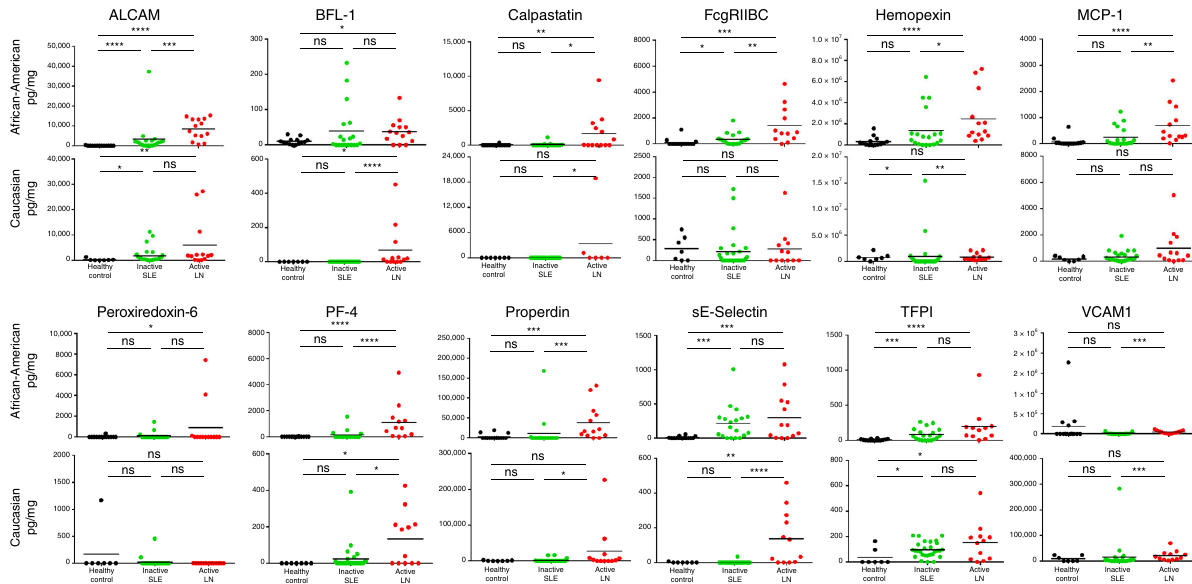
Fig. 2 ELISA validation of elevated urinary proteins in African-American and Caucasian lupus nephritis patients. Plotted are ELISA-validation results for 12 urine proteins in African-American and Caucasian subjects. Each protein was tested using the following sample group: 27 active SLE samples (14 African-American, 13 Caucasian), 47 inactive SLE samples (19 African-American, 28 Caucasian), and 21 healthy controls (14 African-American, 7 Caucasian). The plots show the mean concentration in urine for each disease group after normalizing against urinary creatinine. * p < 0.05, ** p < 0.01, and *** p < 0.001, as determined using Mann – Whitney U -test. Further details regarding these proteins are included in Supplementary Data. Source data are provided as a Source Data fi